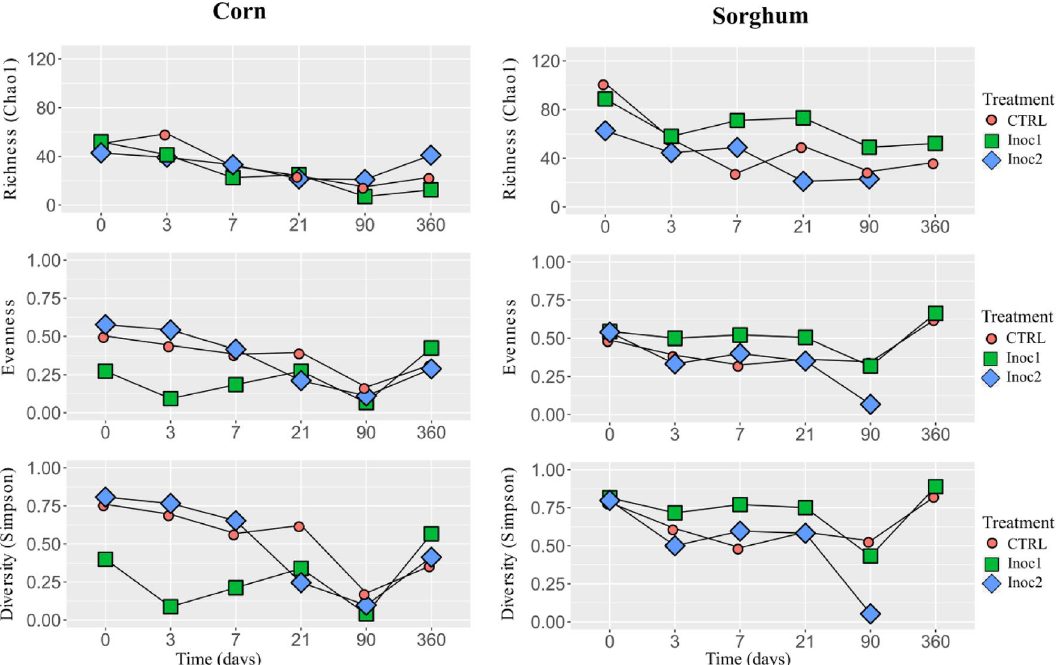
Figure 5. Fungal Chao 1 Richness, evenness, Simpson diversity of rehydrated corn and sorghum grain silages throughout the fermentation period (0, 3, 7, 21, 90 and 360 days). CTRL non-inoculated, Inoc1 Lactobacillus plantarum and Propionibacterium acidipropionici , Inoc2 Lactobacillus buchneri